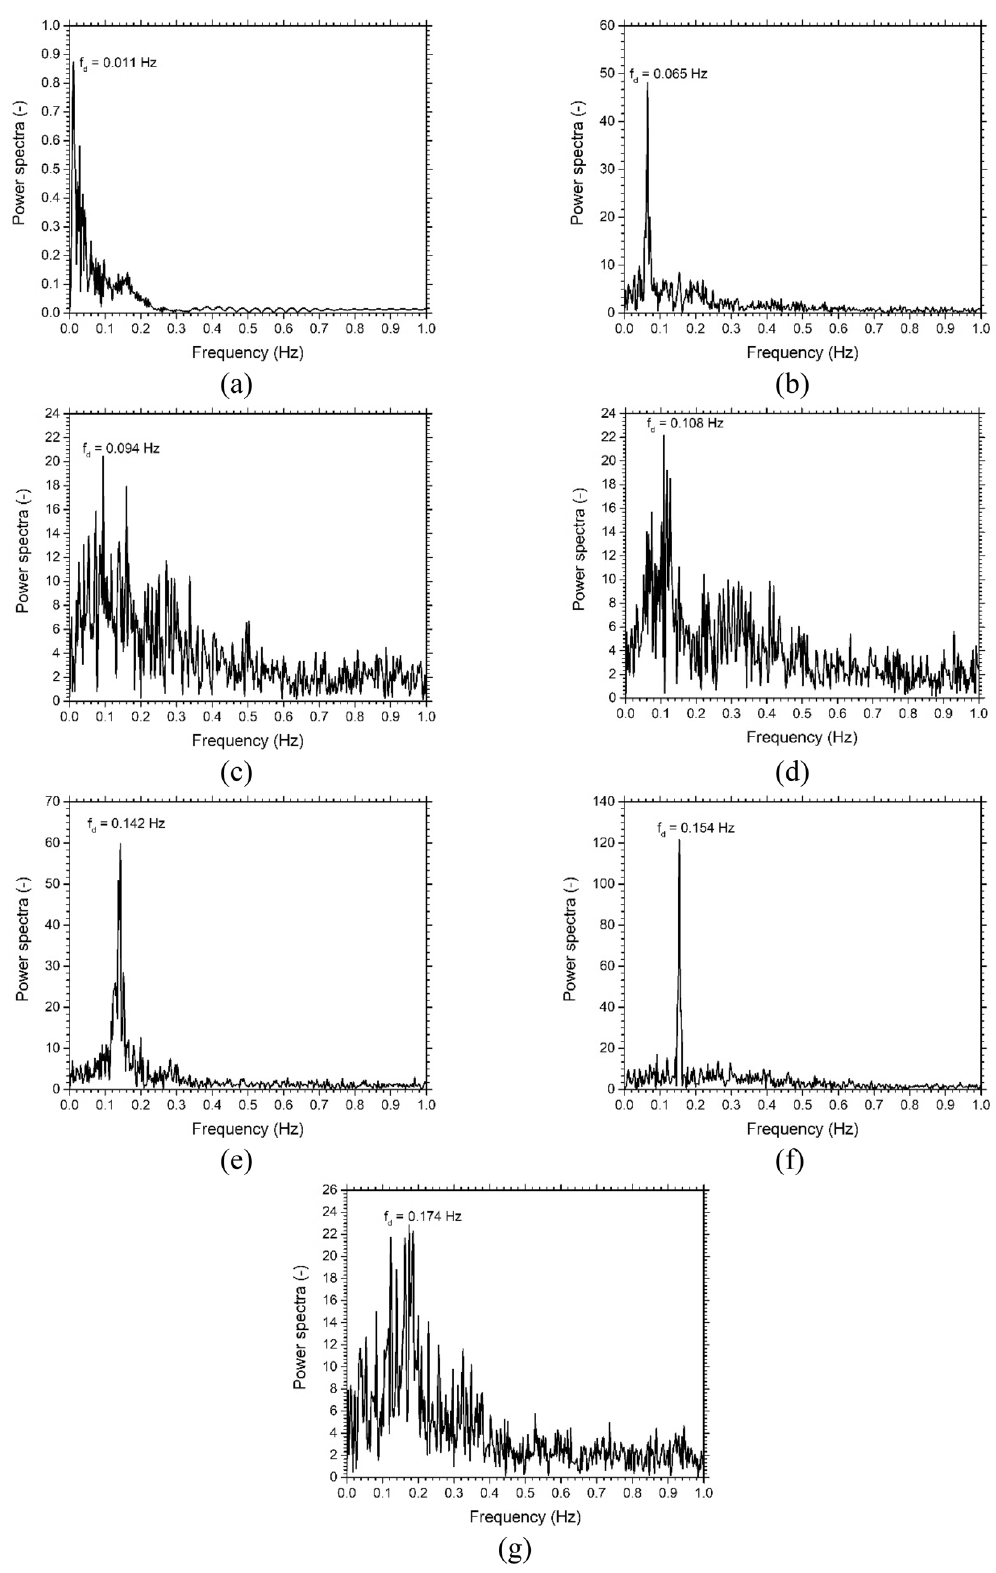
Fig. 10 Power spectra of liquid velocity fluctuations in the column (y = 0.1584, X A3 (85%), d A4 (69%), e A5 (59%), f A6 (44%) and g A7 (18%) (U